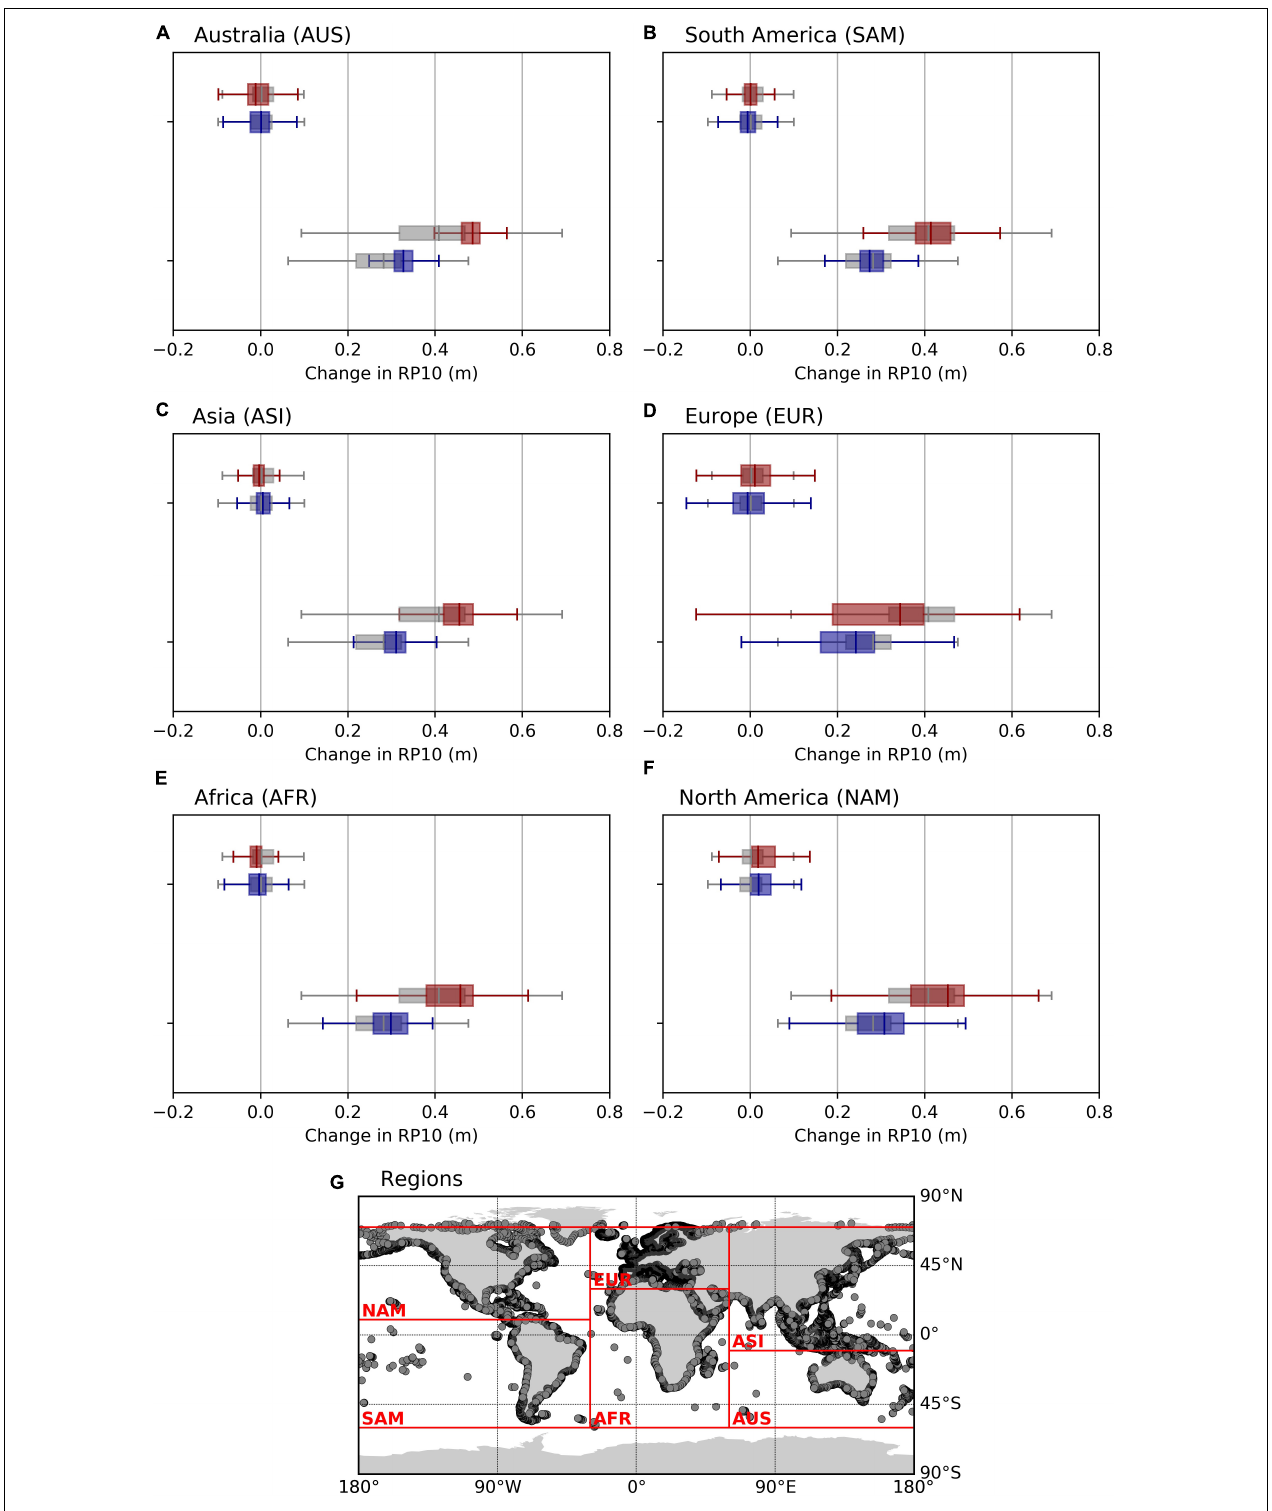
FIGURE 8 | Changes in the 1 in 10-year water levels (RP10) for different geographical regions, which are indicated in panel G . The regions shown are (A) Australia, (B) South America, (C) Asia, (D) Europe, (E) Africa, and (F) North America. We show the changes for the mid-century (2041–2070 with SLR of 2055) based on CoDEC-RCP8.5 compared to CoDEC-HIST (blue bars) and for the end of the century (2071–2100 with SLR of 2085) based on CoDEC-RCP4.5 compared to CoDEC-HIST (red bars). The gray bars indicate the global average. The box plots extend from the lower to upper quartile values of the data, with a line at the median. The whiskers indicate the 5th–95th